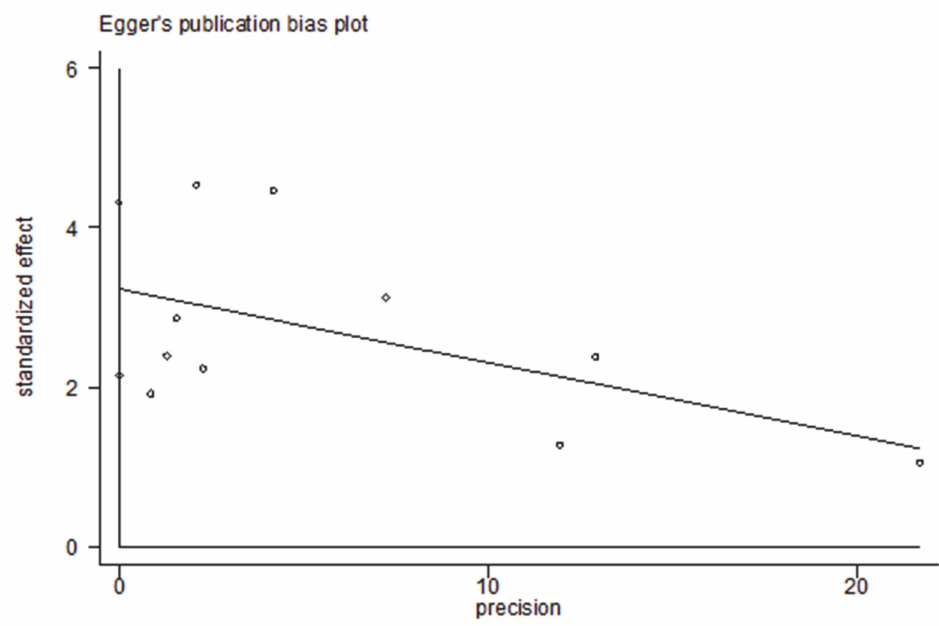
Figure 4. Egger’s test of the meta-analysis on PCT and severity of COVID-19 ( p =